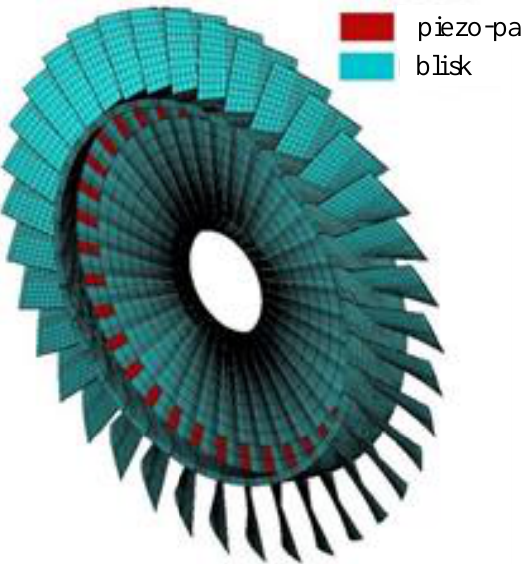
Figure 2. Diagram of the aero-engine bladed disk (blisk).